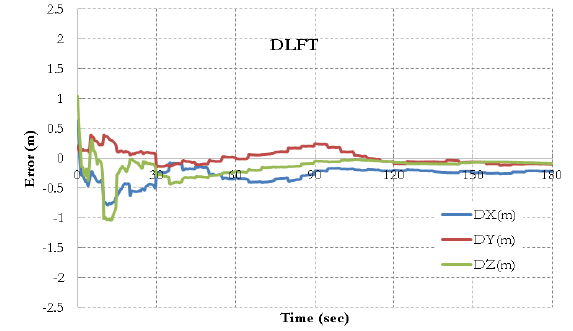
Figure 3. GPS/Galileo PPP results using empirical sine function stochastic model